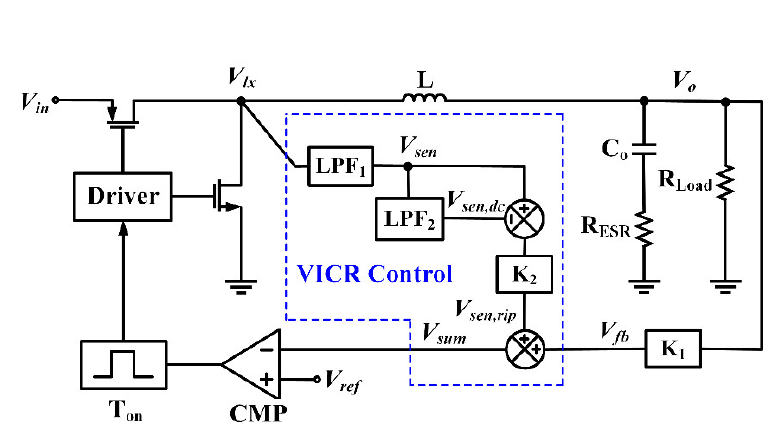
Figure 2. RBCOT buck converter with virtual inductor current ripple (VICR) control.